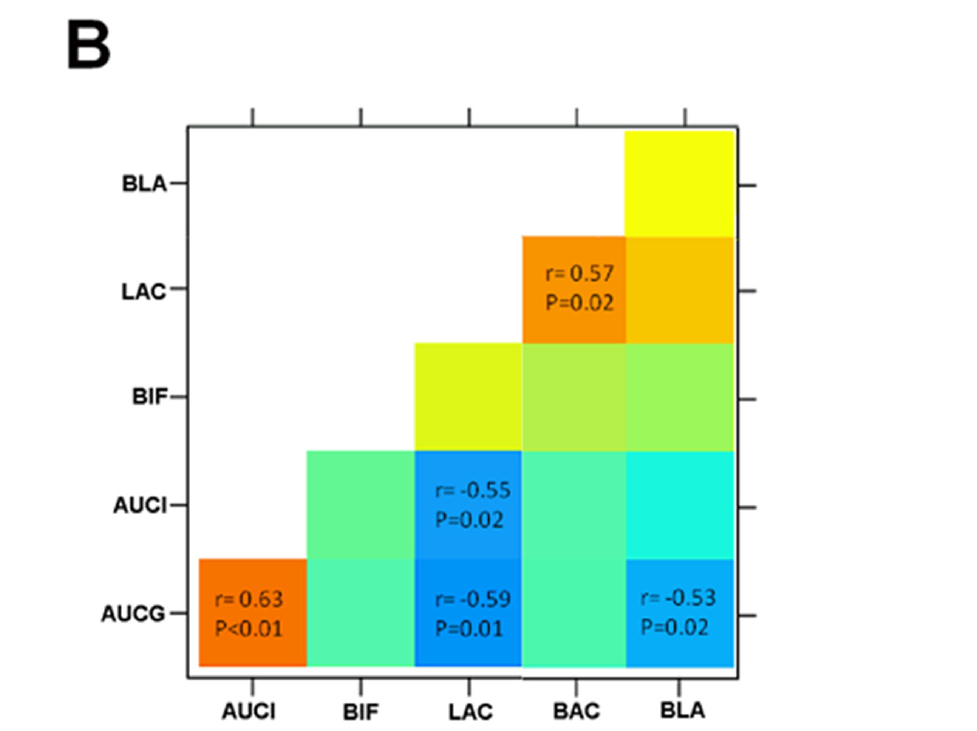
Figure 5. Heat maps showing correlations between the gut microbiome and glucose and insulin serum values. ( A ) Volunteers receiving water for ten weeks showed that AUCG positively correlated with AUCI and inversely associated with Lactobacillus acidophilus (LAC). Bifidobacterium longum (BIF) had a positive correlation with LAC. ( B ) Volunteers drinking sucralose every day for ten weeks showed a positive association of AUCG with AUCI. Moreover, AUCG inversely correlated with LAC and Blautia coccoides (BLA). AUCI exhibited a strong inverse relationship with LAC, while LAC showed a significant positive correlation with Bacteroides uniformis (BAC). We calculated coefficients ( r ) and p values by using the Spearman’s correlation model. Inverse correlations are stronger as blue color increases, whereas positive correlations are stronger as red color increases. We considered a correlation as significant when p < 0.05. AUCG, area under the curve of glucose; AUCI, area under the curve of